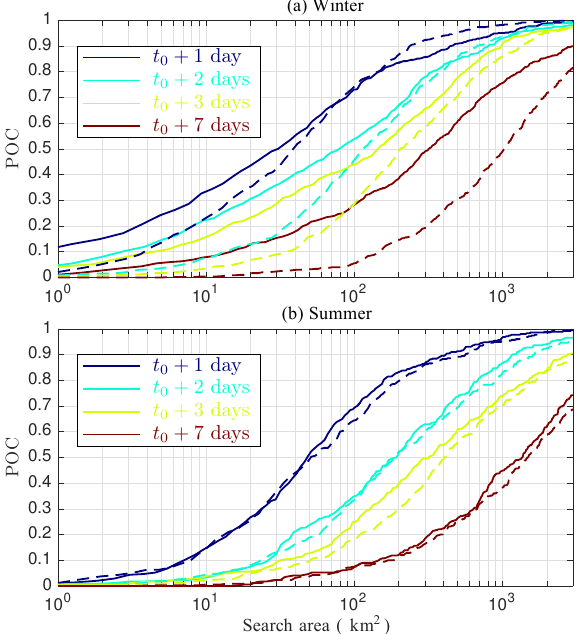
Figure 19. Time evolution of POC according to the search area for neXtSIM (solid lines) and FD (dashed lines) in winter (a) and in summer (b) for different time horizons.